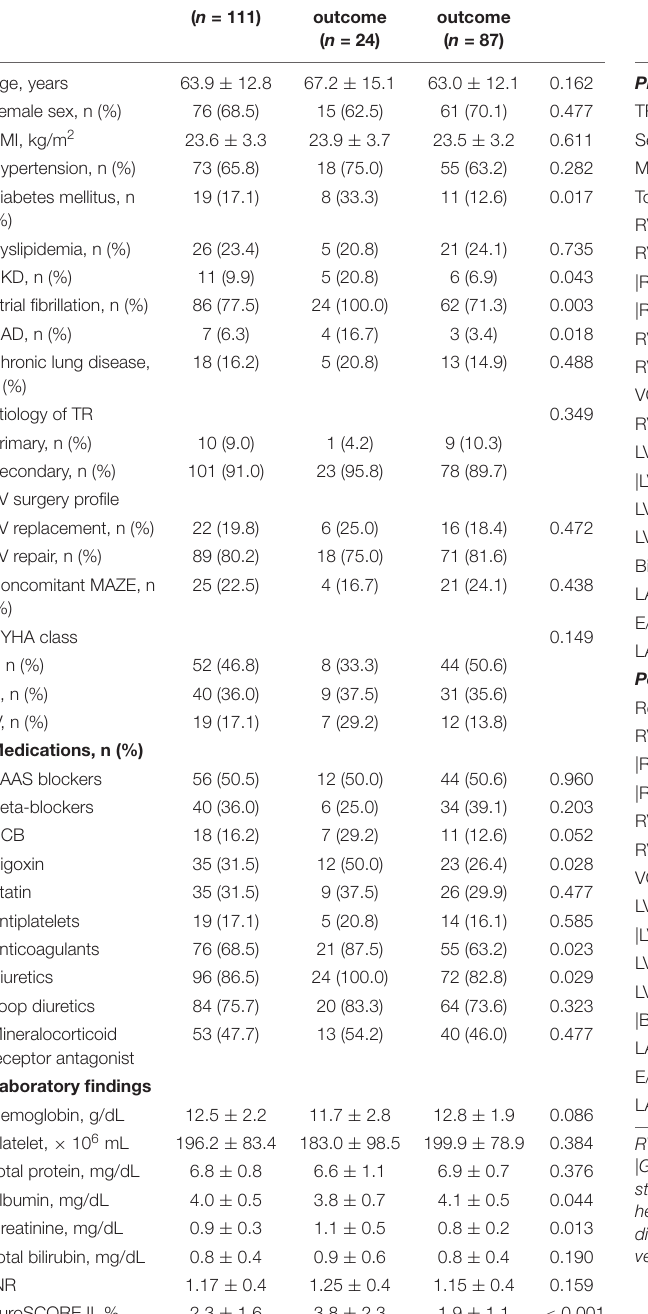
were graded with “massive” TR. Patients with primary outcomes had more-dilated LV chambers, lower RV FAC, |RV-GLS|, |RV-FWS|, and biventricular |GLS| than those without primary outcomes. In the postoperative echocardiography, residual TR was reported in 29 (26.1%) patients. Patients with primary outcomes had larger LA and lower RV FAC, |RV-GLS|, |RV-FWS|, |LV-GLS|, biventricular |GLS|, and LA reservoir strain than those without primary outcomes. Changes in strain parameters of the total study population are shown in Supplementary Figure 1